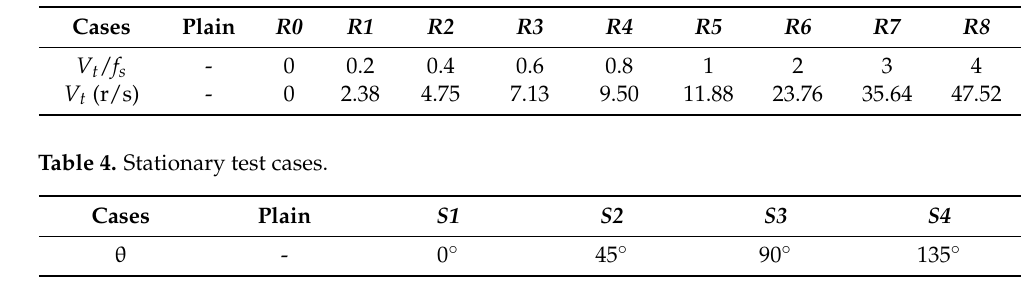
Figure 4. Simulation cases: ( a ) Stationary cases; ( b ) Grid surrounding square cylinder. Table 3. Rotating test cases.